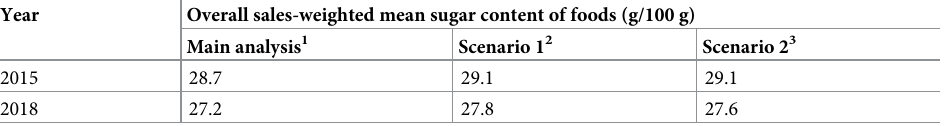
Table 6. AU : Pleasecheckthattheeditstothetitle ; columnheads ; andfootnotesofTable 6 captureyourmeaning : Ifnot ; pleaseeditasnecessary : Main analysis results of sales-weighted mean sugar content of foods in 2015 and 2018 compared to the results of 2 sensitivity